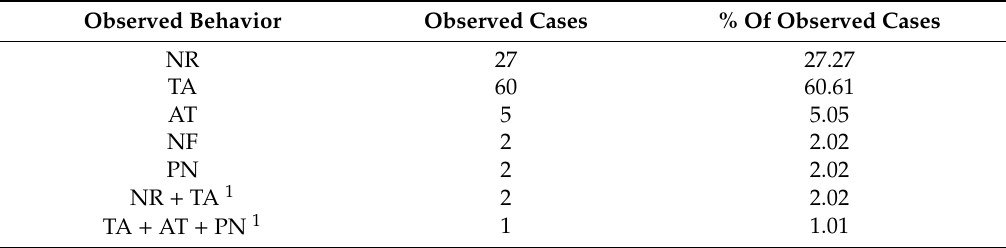
Table 4. Observed antagonistic behavior between Capercaillie females in the nest area during laying and incubation